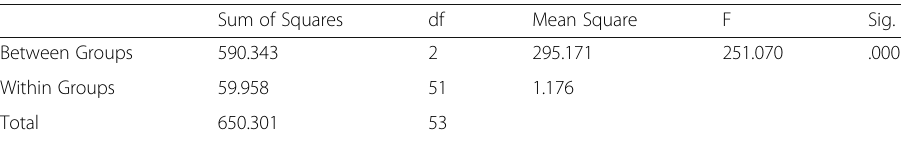
Table 8 One-way ANOVA (delayed post-tests) Sum of Squares df Mean Square F Sig. Between Groups 590.343 2 295.171 251.070 .000 Within Groups 59.958 51 1.176 Total 650.301 53